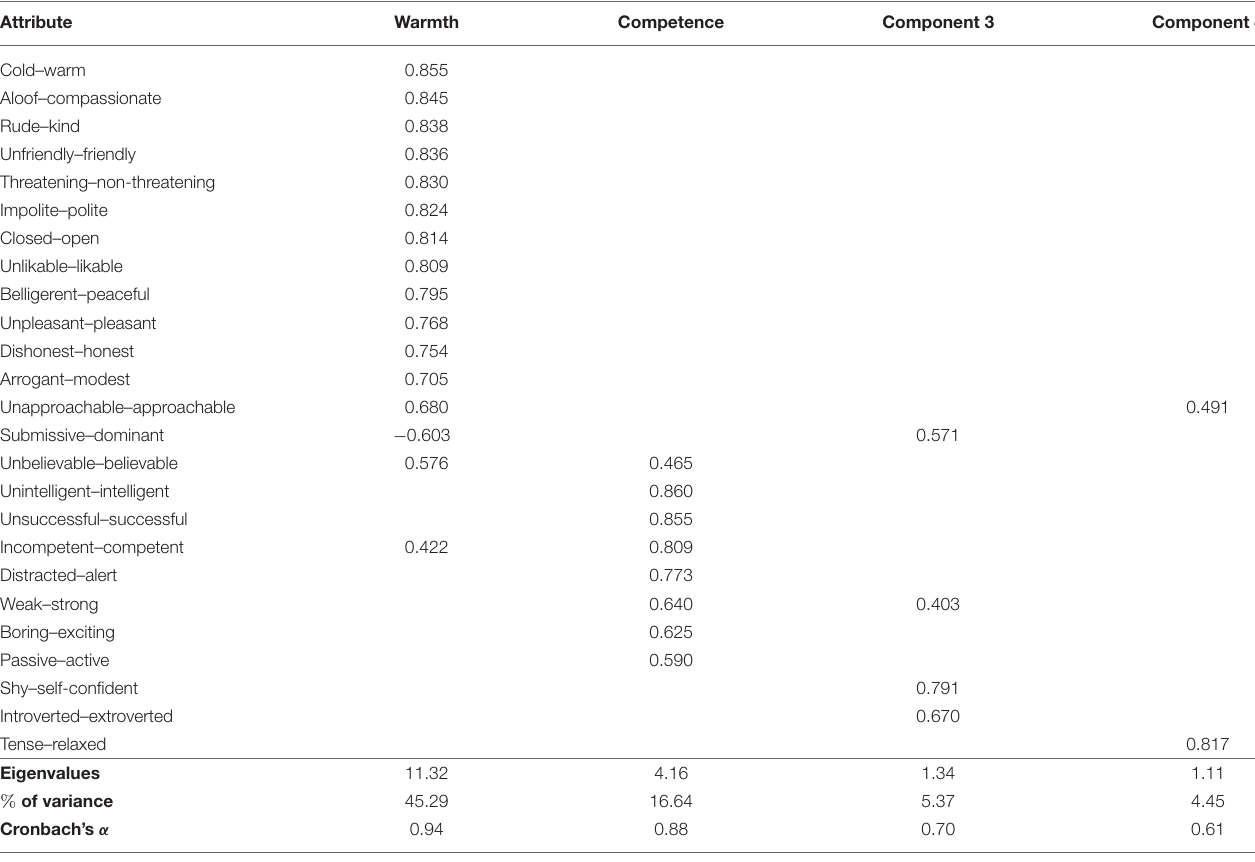
TABLE 2 | Principal component analysis of the social perception scale: Rotated component loadings.